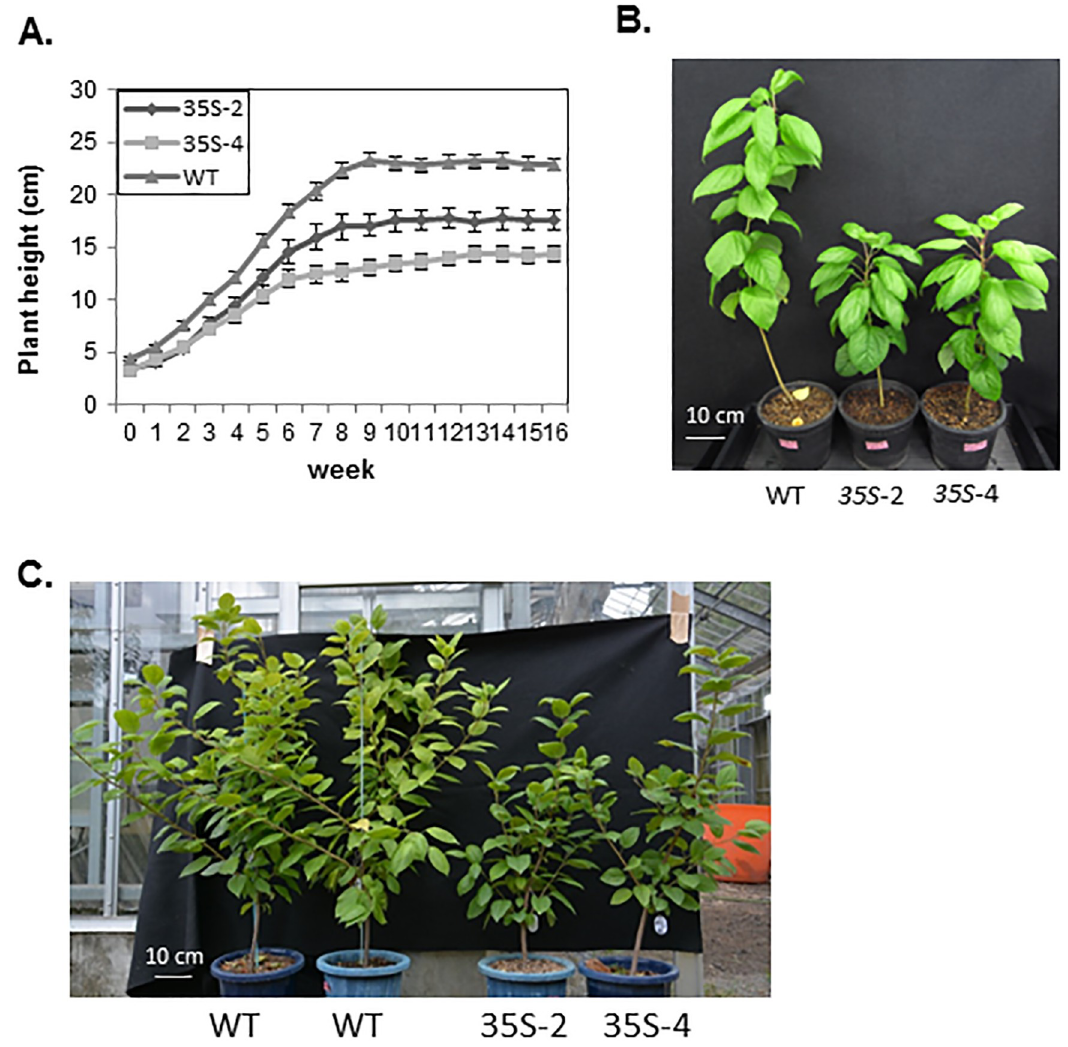
Fig 1. Inhibited shoot growth and reduced plant size of 35S : PmDAM6 apple plants. (A) Shoot growth was inhibited in the 2-year-old 35S : PmDAM6 lines, 35S-2 and 35S-4, relative to the growth of wild-type (WT) plants, under long photoperiod (16-h light/8-h dark) conditions. Plant height of 35S-2 and 35S-4 were significantly lower (P < 0.01) than those of WT in all examined periods (Student’s t -test) (B) Photographs of 3-year-old plants taken after they stopped growing under short photoperiod (SP) (8-h light/16-h dark) conditions. 35S : PmDAM6 plants were shorter than the WT plants (right). (C) Photograph of 5-year-old plants taken on 28 August 2015. The 35S : PmDAM6 plants were shortened than the WT plants. Plants were grown in a greenhouse without heating, resulting in exposure to naturally occurring cold conditions in the